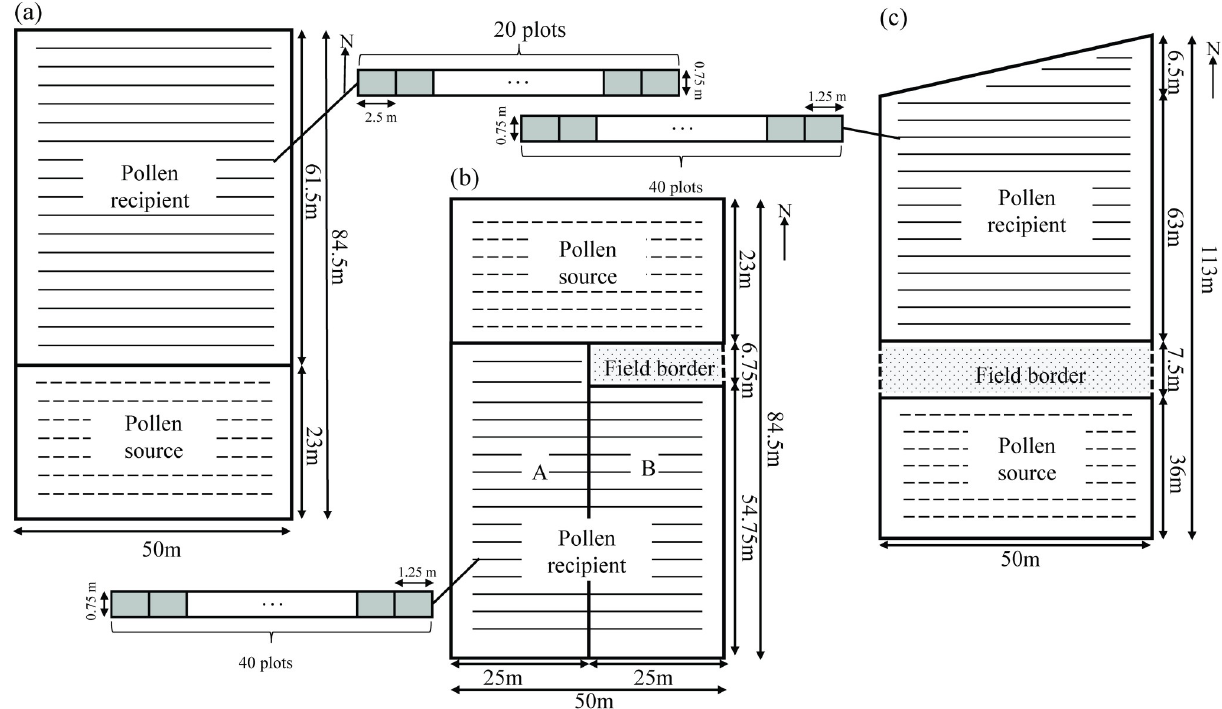
Fig 1. Field design and sampling plots layout for the experiments. Crop seasons (a) 2009–1, (b) 2009–2, and (c) 2010–1. The solid line indicates the pollen recipient, the dashed line indicates the pollen source, and the network node indicates the FB. The example of sampling plots layout is illustrated in the first row of each